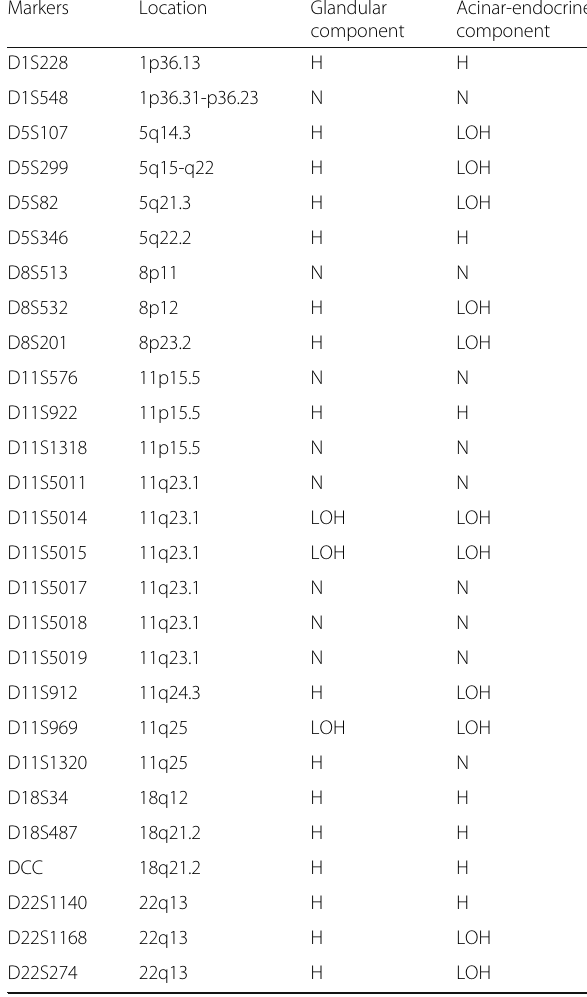
Table 2 Results of allelic imbalance analyses Markers